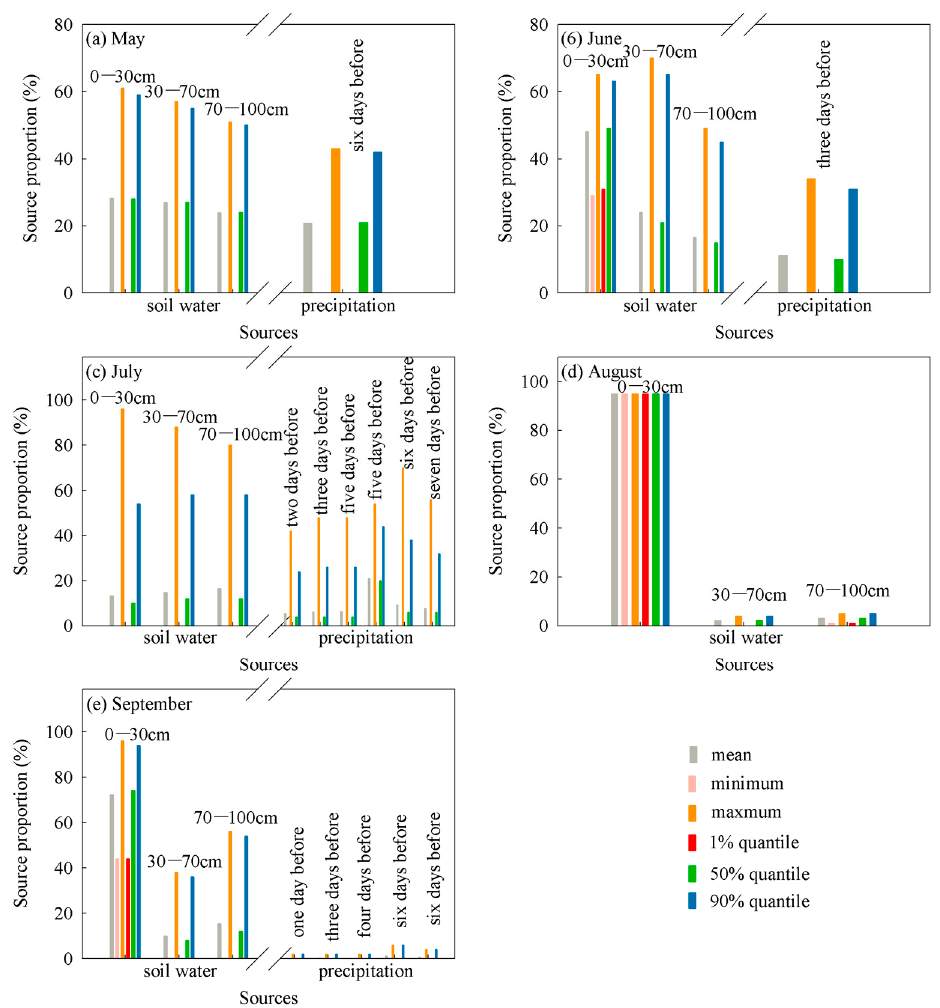
Figure 12. The fraction of plant water use from the di ff erent soil layers (0–30 cm, 30–70 cm, 70–100 cm) and precipitation at Tianzhu. ( a – e ) represents May, Jun, July, August and September, respectively.